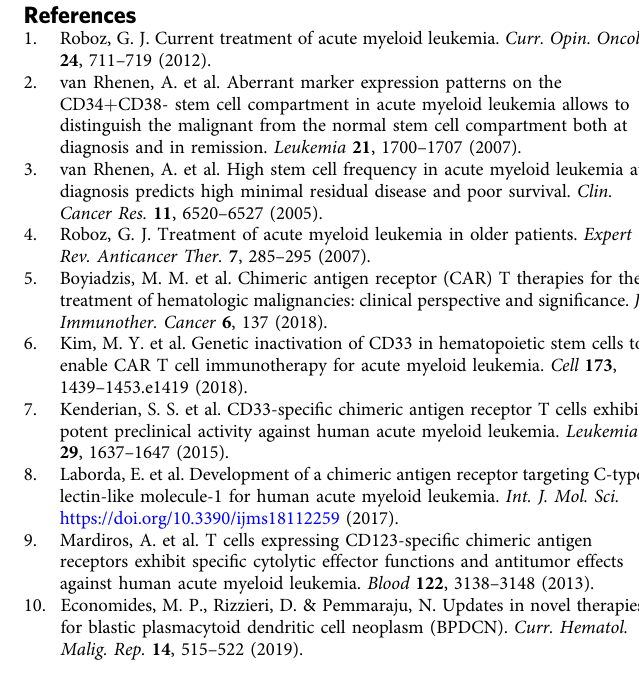
Fig. 4 UCART123 killed primary AML selectively in co-engrafted model with human normal hematopoiesis and human AML. a Schematic representation for the competitive BM and AML model. Normal CD34 + bone marrow cells (nBM) (6×10 6 cells, HLA-A2-) were co-injected with T-cell depleted human AML cells (2.5×10 5 cells, HLA-A2 + ) into sub-lethally irradiated NSG mice. After 7 weeks, mice were treated with PBS, 1×10 6 UCART123 or 1×10 6 TCR αβ KO T-cells. Normal hematopoietic cells and leukemia cells in PB and BM were monitored with fl ow cytometry starting on day 2 and later every 1 – 2 weeks. b Human cells gated with mouse CD45 versus human CD45 (left) were evaluated for CD123 expression level after normal cells (HLA-A2 − , blue rectangle) and leukemic cells (HLA-A2 + , red rectangle) were distinguished (right). Leukemic cells express higher CD123 levels than normal cells and were preferentially eliminated by UCART123 (right bottom). c Normal cells and leukemic cells were tracked in PB by fl ow cytometry starting on day 2 and at indicated timepoints. Leukemic cells outcompeted normal cells over time in PBS and TCR αβ KO cohorts; cohort size: n = 5 PBS, n = 8 TCR αβ KO, n = 10 UCART123. d Normal cells and leukemic cells were evaluated in BM on day 36 post treatment. PBS ( n = 5) and TCR αβ KO ( n = 8) cohorts showed progression of leukemia, while UCART123 ( n = 10) treated mice did not (top). Evaluation of subsets in BM showed 2-fold decrease in CD33 + myeloid cells in UCART123-treated mice, while lymphoid lineages were not impacted. Each symbol represents a mouse and bar represents the mean with the SD. *** p <0.001, * p <0.05, one-way ANOVA. Source data are provided as a Source Data fi